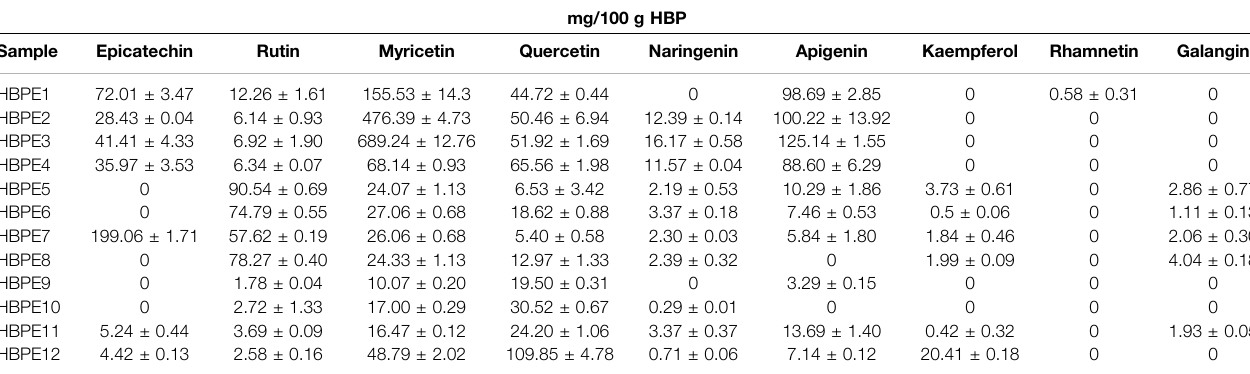
TABLE 4 | Flavonoids of honeybee pollen extracts (HBPEs) as determined by